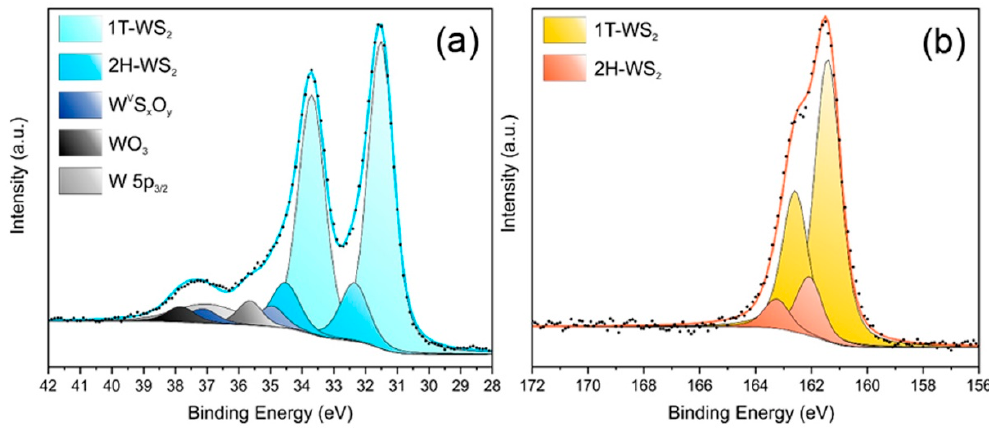
Figure 5. XPS spectra of exfoliated WS 2 W 4f ( a ) and S 2p ( b ) photoemission lines.